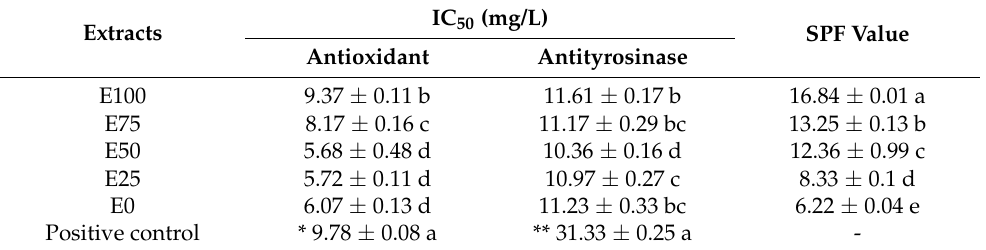
Table 2. Antioxidant, tyrosinase inhibition, and SPF value of I. bijuga extracts.